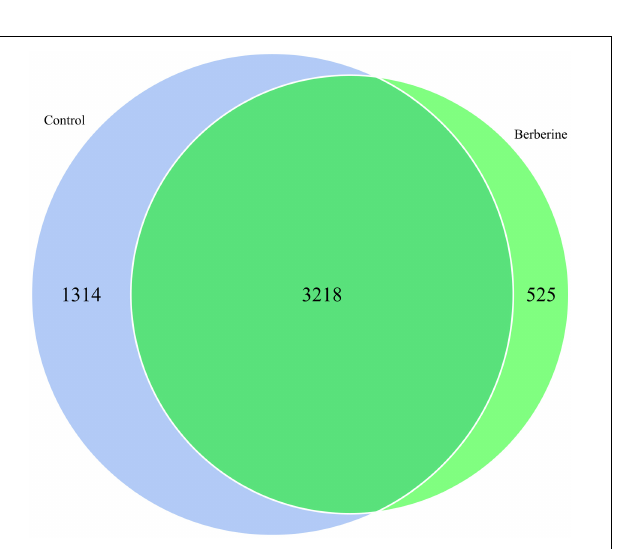
FIGURE 3 | Species Venn analysis between control and berberine